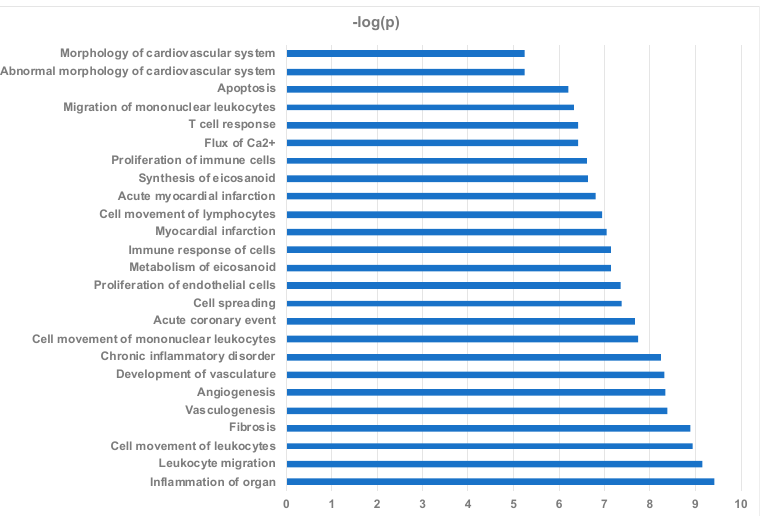
Figure 7. Biological functions affected by surgical myectomy. Biological functions that are signifi- cantly enriched by the 79 input protein list ranked by − log p value.